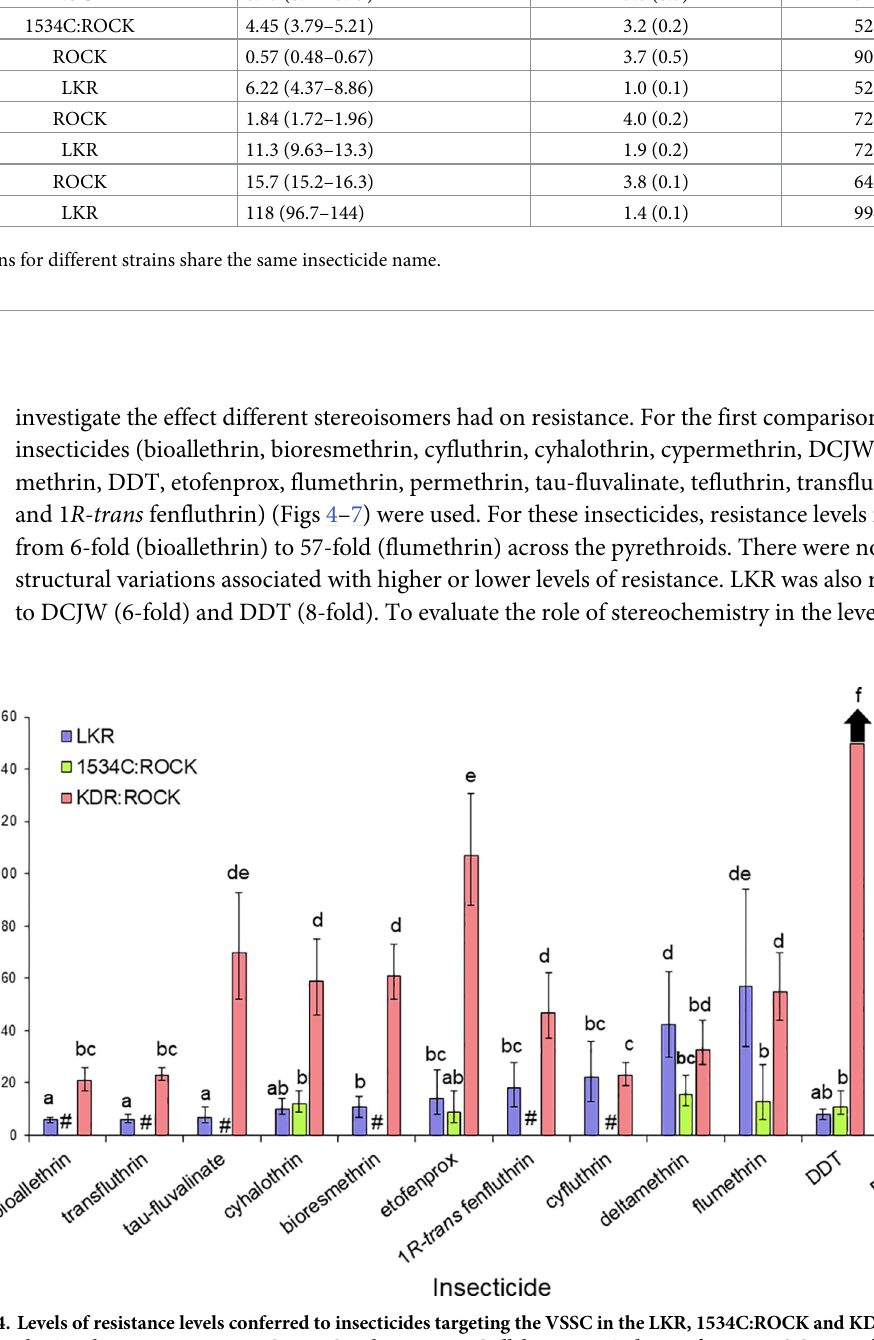
Fig 4. Levels of resistance levels conferred to insecticides targeting the VSSC in the LKR, 1534C:ROCK and KDR:ROCK strains having the 410L+1016I+1534C, 1534C and 989P+1016G alleles, respectively. RRs for KDR:ROCK are calculated from the values in Table 3 or were previously published [25] and are given here for comparison purposes. RRs for 1534C: ROCK for bioallethrin, cyhalothrin, etofenprox, flumethrin, DDT and DCJW were previously reported [24] and are given here for comparison purposes (those that were not tested are indicated by a #). Bars with different letters are significantly different based on non-overlap of the 95% confidence